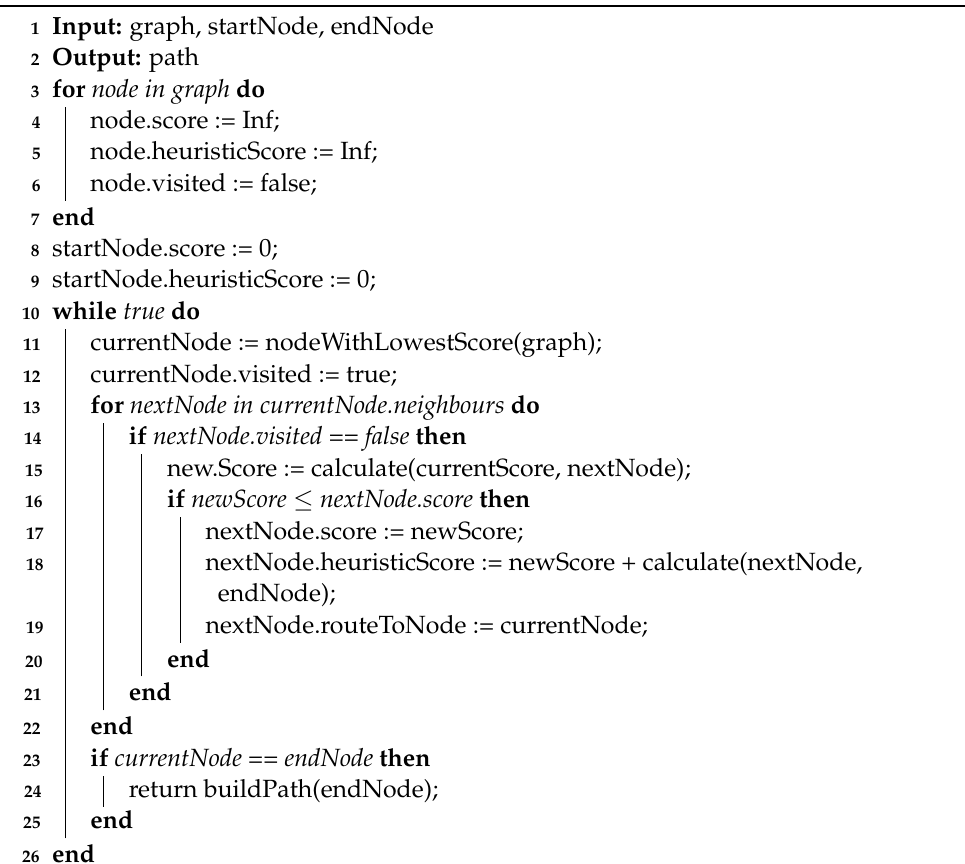
Algorithm 1: The proposed PPA